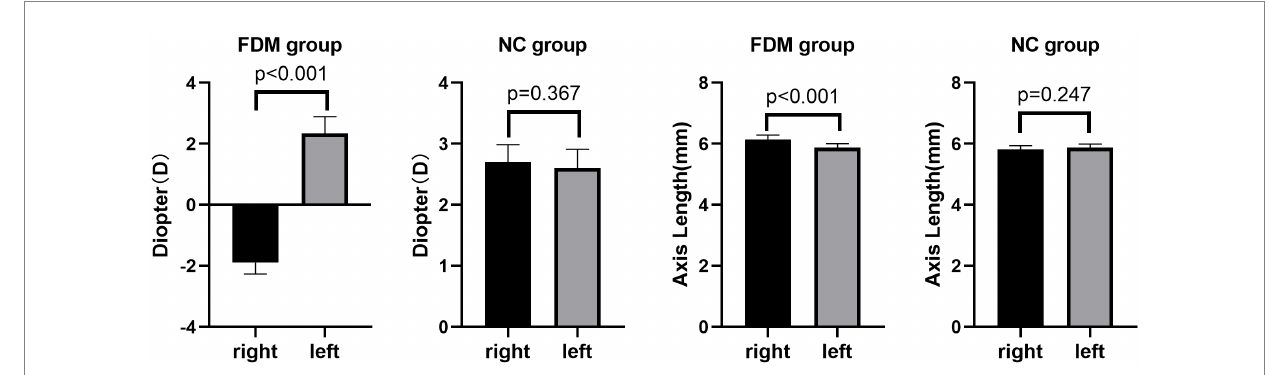
FIGURE 1 Comparison of binocular axial length and diopter in the two groups. In the FDM group, the mean diopter of the right eye was − 1.89D and that of the left eye was 2.34D. In the NC group, the mean diopter of the right eye was 2.70D and that of the left eye was 2.60D. In the FDM group, the mean axis length of the right eye was 6.11 mm and that of the left eye was 5.84 mm. In the NC group, the mean axis length of the right eye was 5.82 mm and that of the left eye was 5.87 mm. FDM, form-deprivation myopia; NC, normal